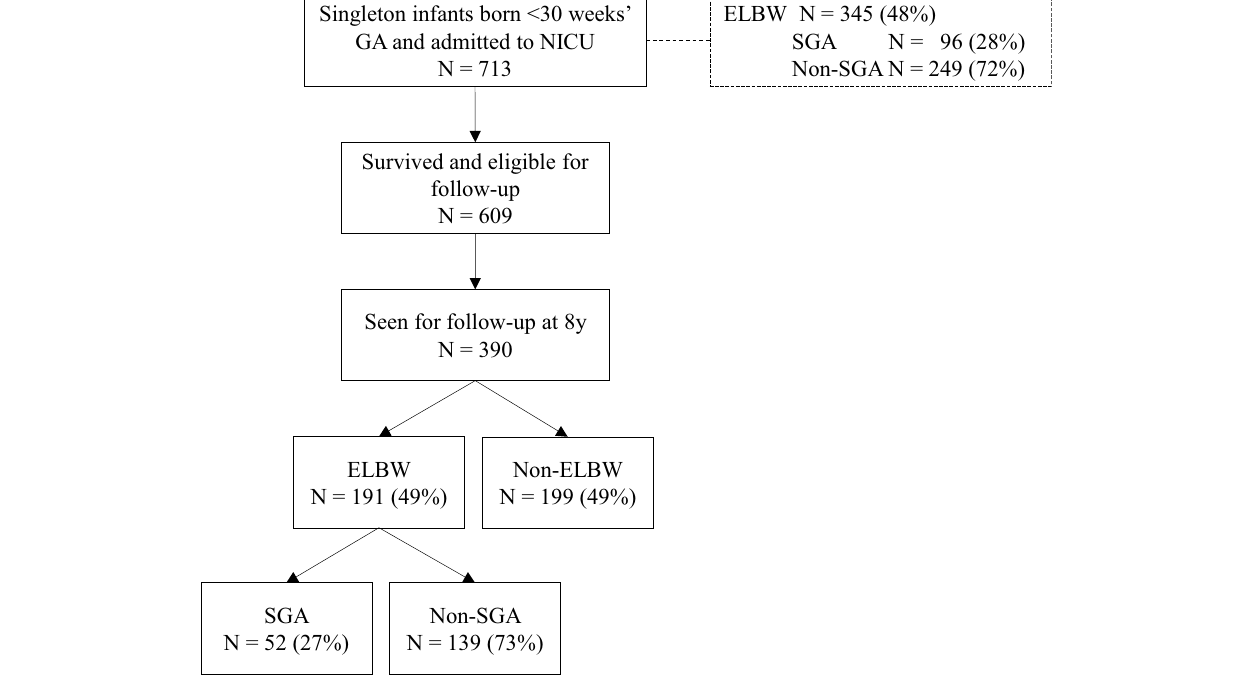
FIGURE 1 | Flowchart of the included